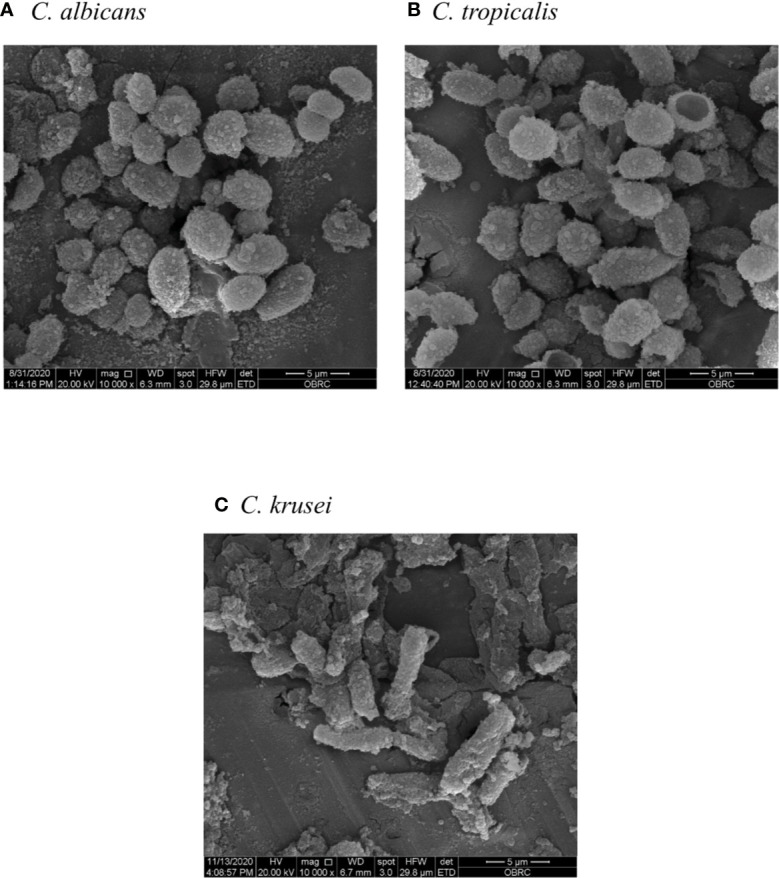
Morphology and size of Candida β-glucans. β-glucans of (A)
Candida albicans, (B)
Candida tropicalis, and (C)
Candida krusei were observed by scanning electron microscopy (SEM) with 10,000x magnification.